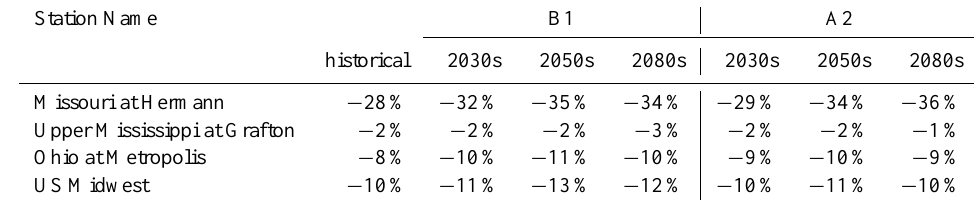
Table 2. Percent change in annual discharge of the simulated regulated flow with respect to the simulated natural discharge.